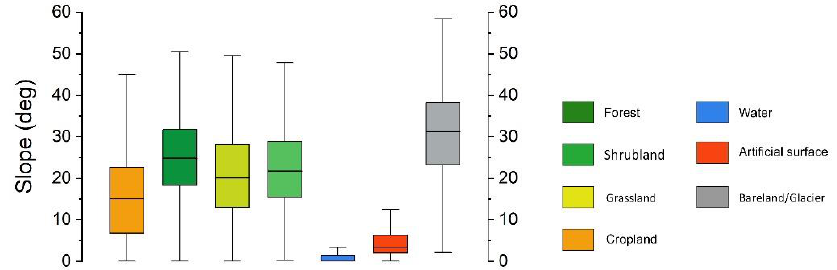
Figure 12. Landcover and its relationship to